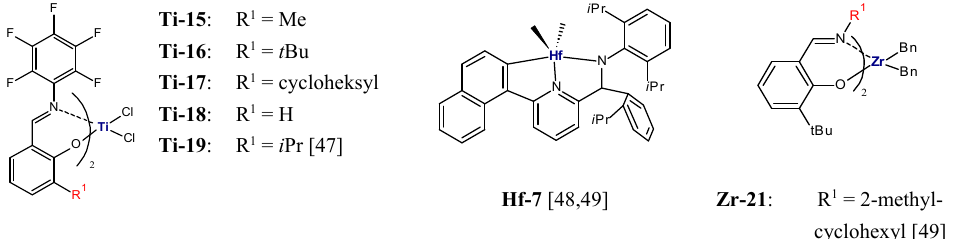
Figure 2. Fluorinated bis(phenoxy-imine) titanium complexes as well as bis(phenoxy-imine) zirco- nium and pyridylamide hafnium complexes used for synthesis of multiblock copolymers [47–49] .